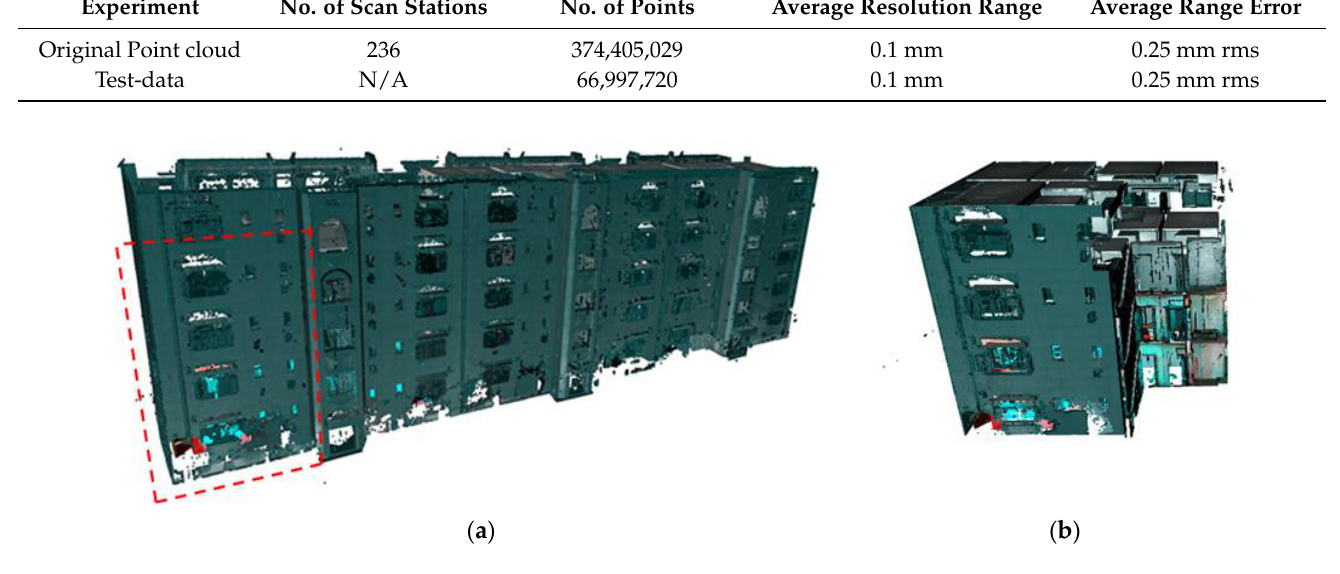
Figure 14. Input point cloud for the experiment: ( a ) Original point cloud; ( b ) Cut portion used in the experiment. the